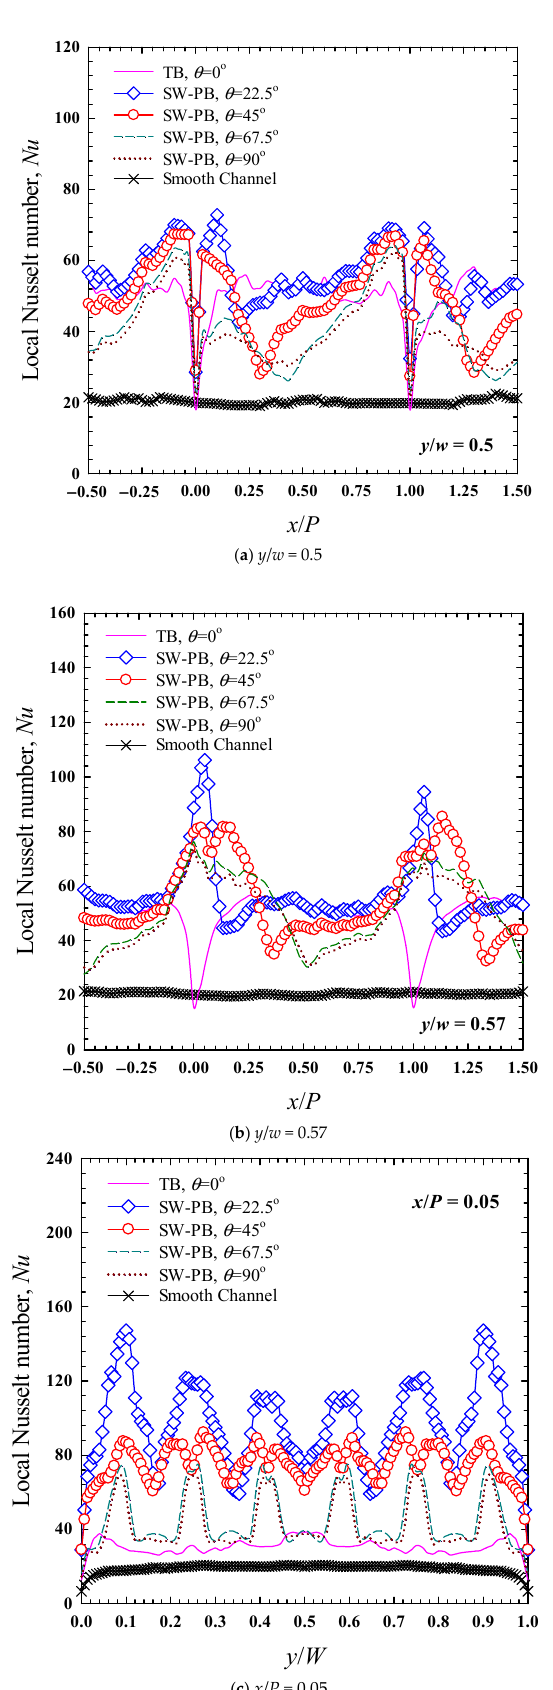
Figure 5. Normalized Nusselt number at y / w = 0.5, y / w = 0.57, and x / P = 0.05 at Re = 6000.